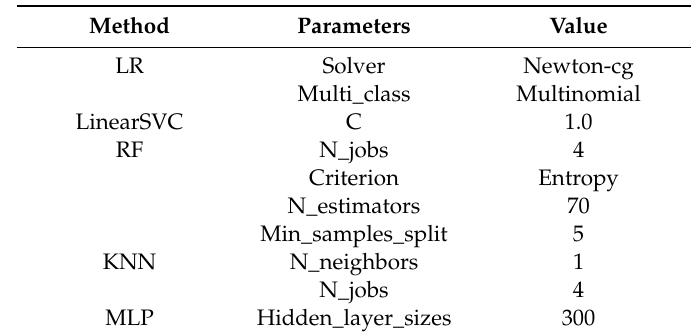
Figure 8. The feature map visualization of Kf. Table 3. The parameters set in the models.